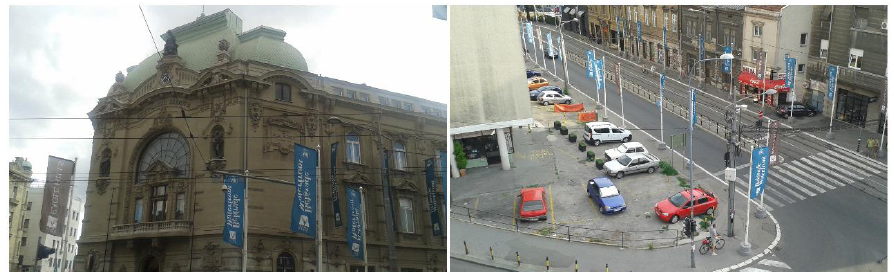
Figure 4. Renovated Belgrade Cooperative Building and banners promoting the Belgrade Waterfront project in the streets of Savamala in 2015 (source: author’s collection, August 2015).